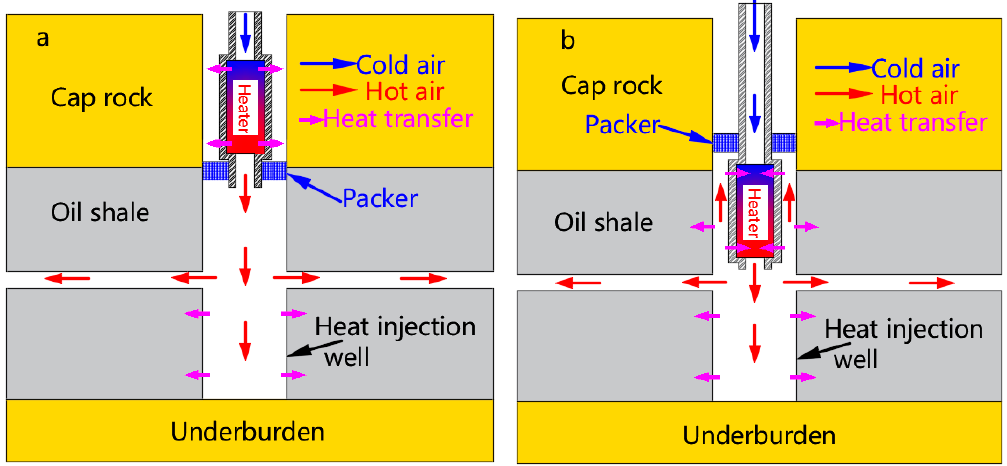
Figure 1. Heat transfer schematic diagram of ( a ) scheme 1 and ( b ) scheme 2.